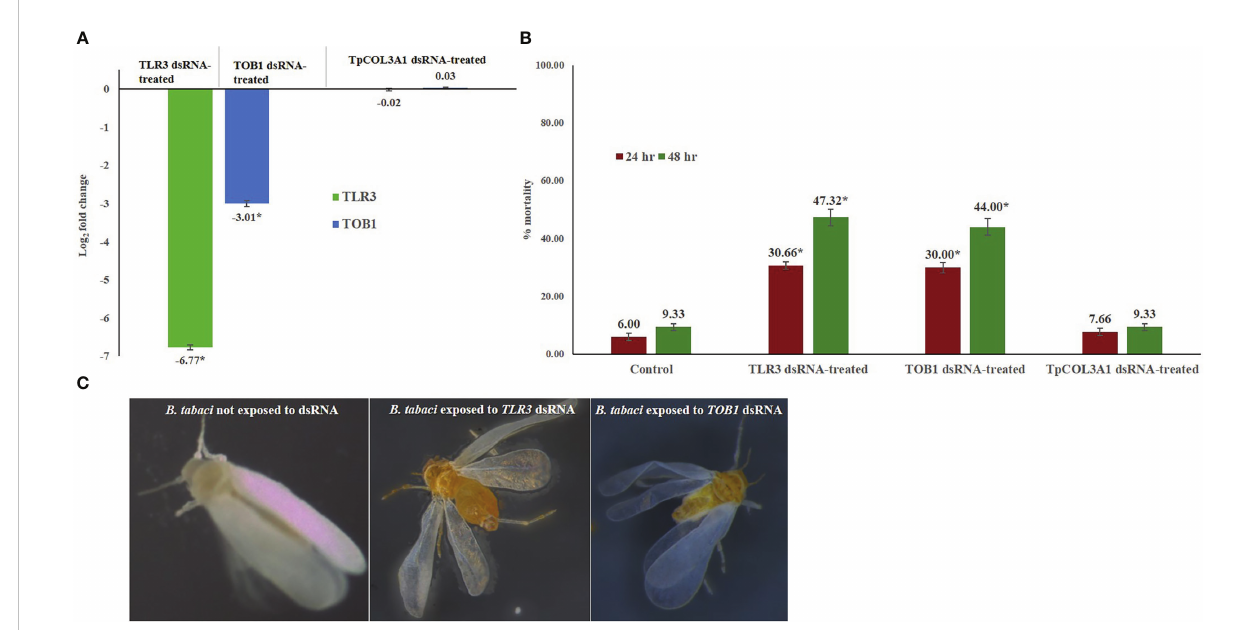
FIGURE 2 Effect of silencing TOB1 and TLR3 on survival of B. tabaci . (A) Normalized relative expression of B. tabaci TOB1 and TLR3 mRNA post 48 hr of dsRNA feeding. (B) Percent mortality of adult B. tabaci post TLR3 and TOB1 dsRNA feeding at 3.0 µg/mL. The mean denoted by an asterisk (*) indicates a signi fi cant difference (p< 0.0001). The error bars are the standard error of the mean (SEM). (C) B. tabaci adults fed on the diet mixed with TLR3 and TOB1 dsRNA and without dsRNA. No morphological deformities were observed in TOB1 and TLR3 dsRNA-fed B. tabaci